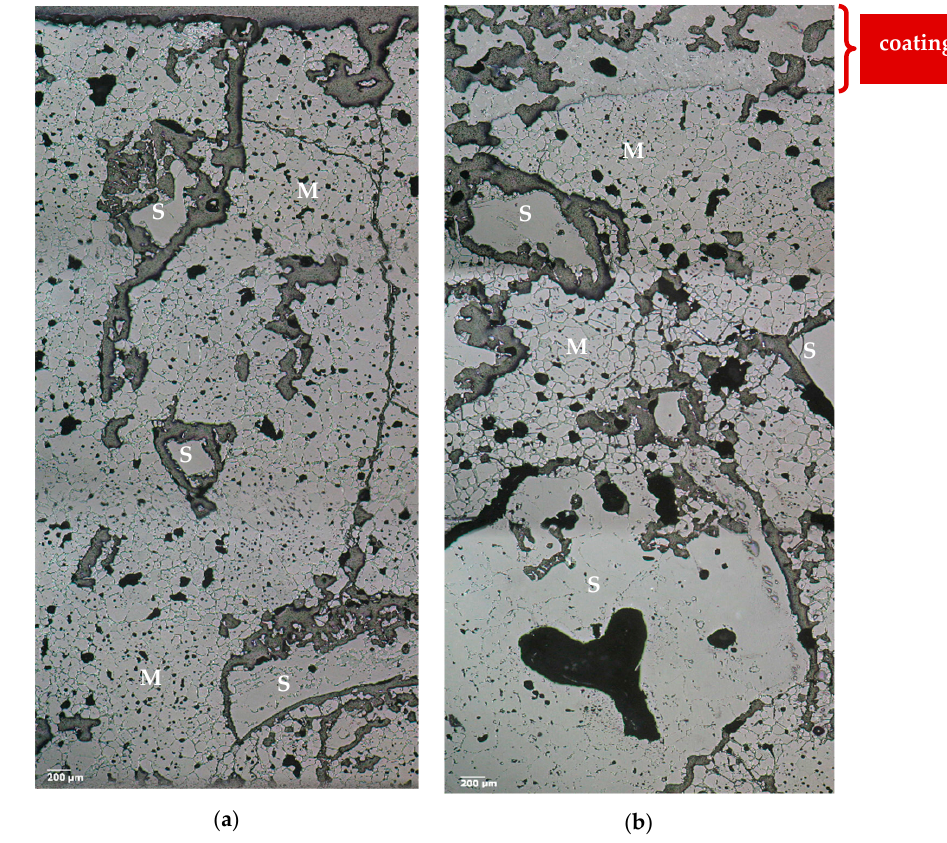
Figure 9. Microstructure of the bricks A ( a ) and B ( b ) after sandwich coating test using cement raw meal as received (M = magnesia, S = fused